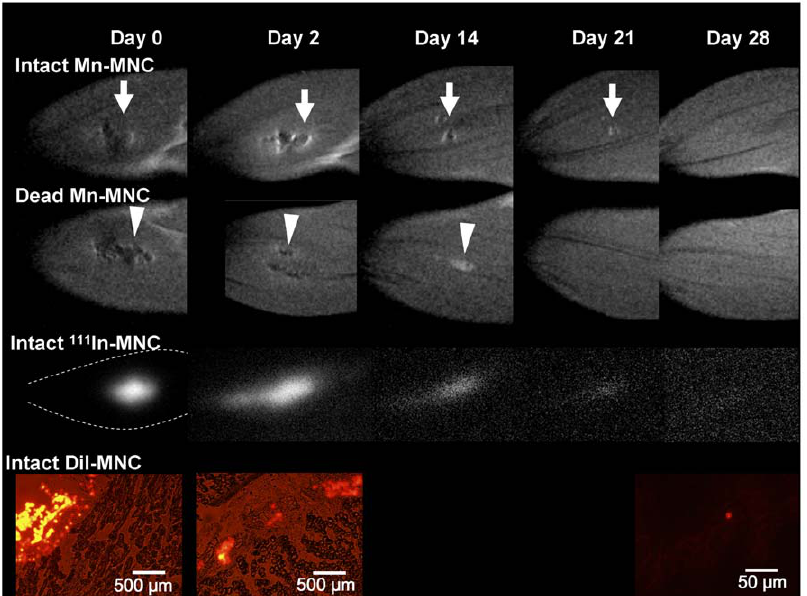
Figure 3. Long-term invivo observations after transplantation of Mn-labeled MNCs in ischemic rat legs. T 1 -weighted images of intact (1 st row) and dead (2 nd row) Mn-labeled MNCs, SPECT images of intact 111 In oxine labeled MNCs (3 rd row), and fluorescence microscopy images of intact DiI-labeled MNCs (4 th row) are presented. The images were obtained between 0 and 28 days after administration. The intact Mn-labeled MNCs were typically observed for at least 7 and up to 21 days in the injected muscle (arrows). The dead Mn-labeled MNCs (arrow heads) tended to decrease in volume earlier than the intact MNCs.